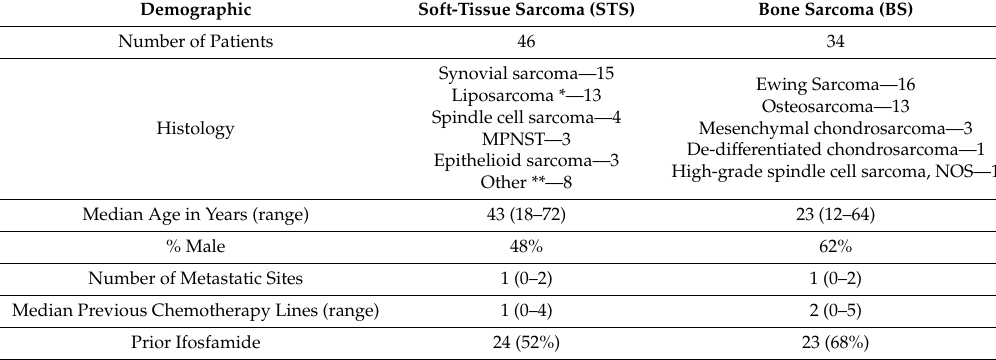
* Liposarcoma: seven patients with de-differentiated liposarcoma, three with myxoid liposarcoma, two with well-differentiated liposarcoma and one with pleomorphic liposarcoma. MPNST: malignant peripheral nerve sheath tumour. NOS: not otherwise specified. ** Other STS: myxofibrosarcoma (2) and leiomyosarcoma (2).